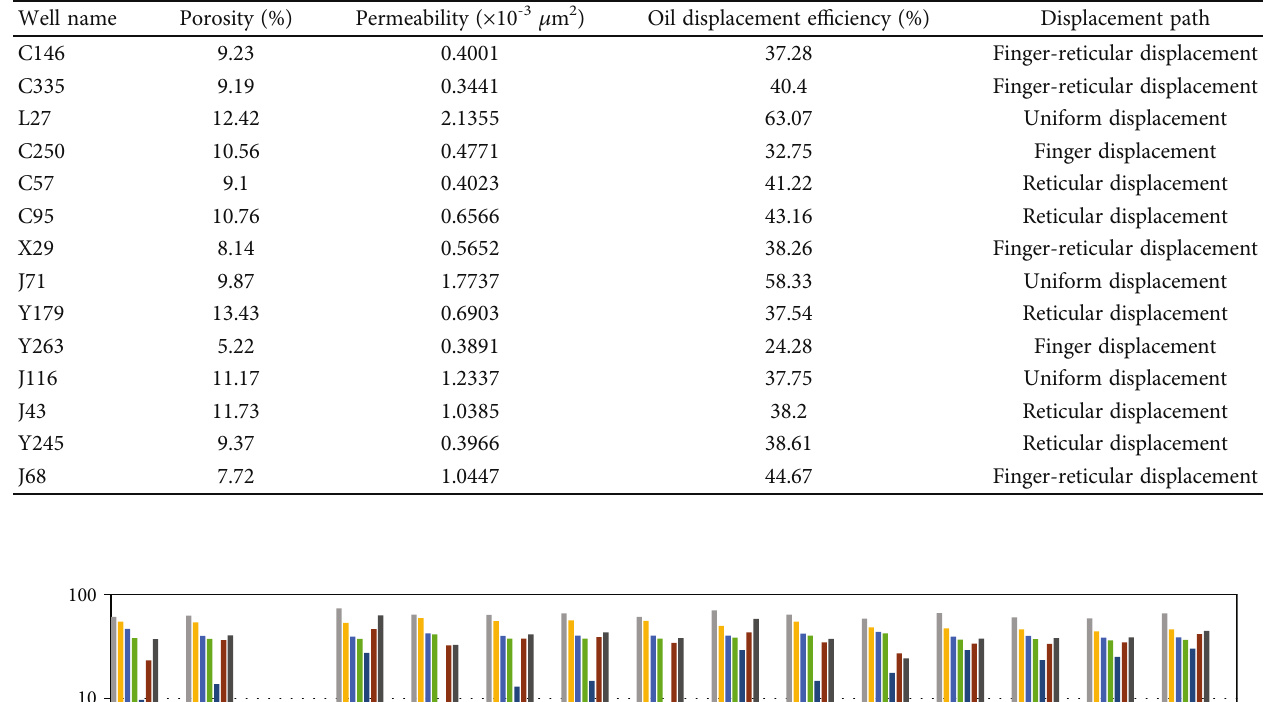
Table 1: Pore structure parameters and displacement path of sandstone.